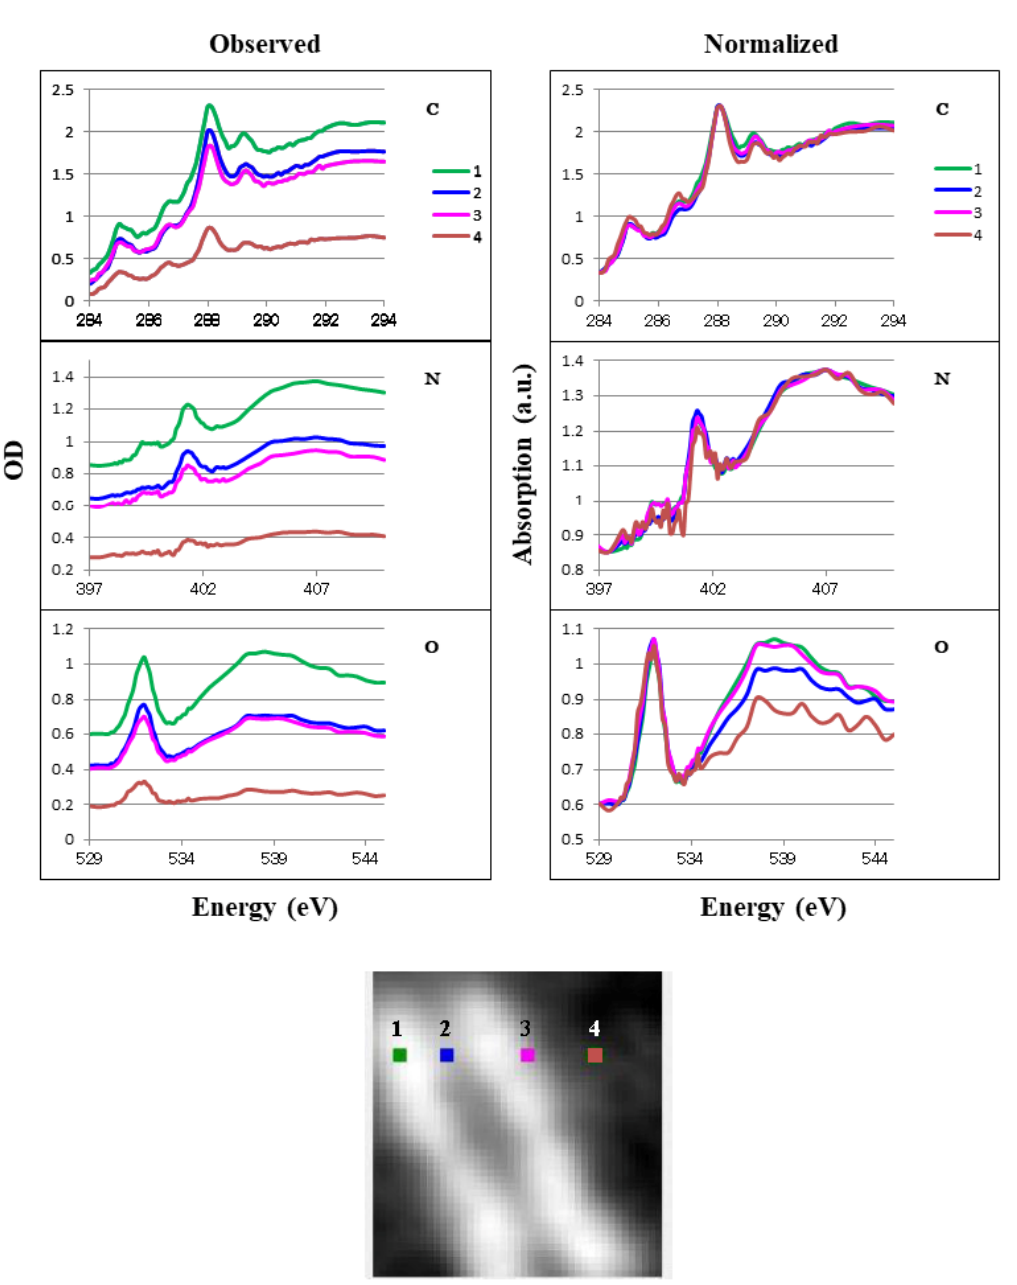
Figure 11. Absorption spectra of local areas in the chromosome. Positions 1–4 are shown in the lower figure (area: 2 × 2 pixels each). Observed data are shown on the left, normalized data on the right. Numbers correspond to the positions in the left arm (1), between the arms (2), in the right arm (3), and outside the chromosome (4). C, N, and O are photon energy regions of the K absorption edges for carbon, nitrogen, and oxygen,